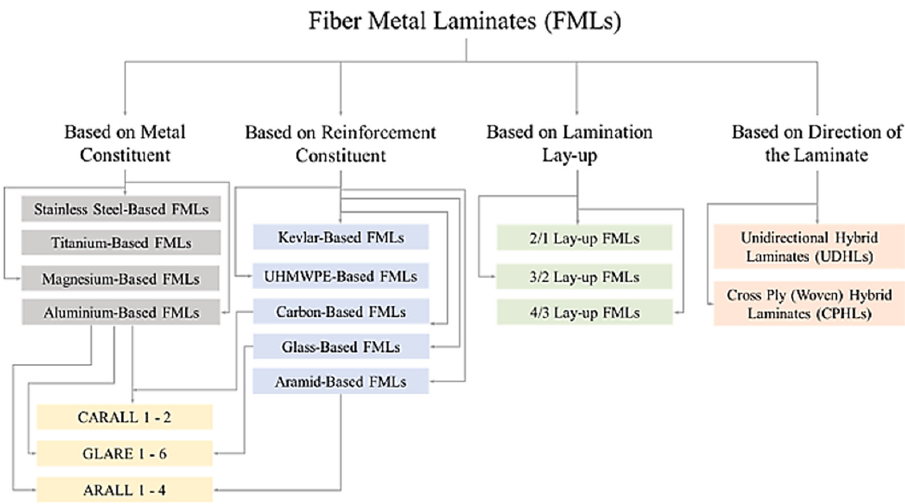
Figure 2. Classification of FMLs [13] .